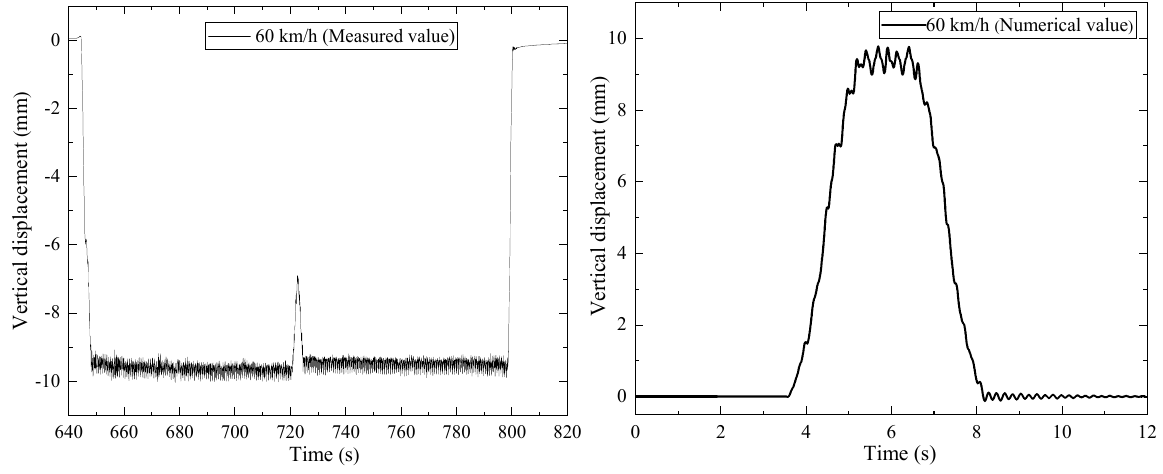
Figure 18. The midspan displacement time-history response of the beam.